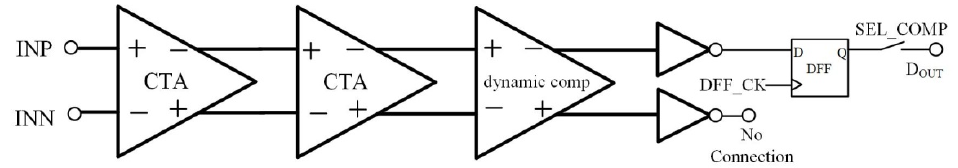
Figure 5. Schematic of the 1-bit quantizer.